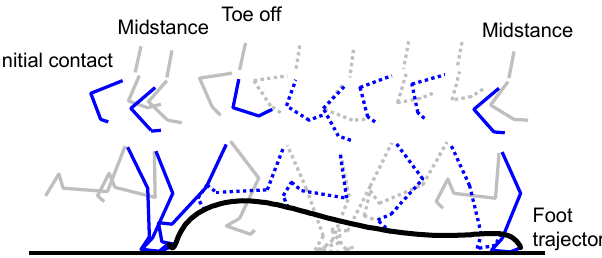
Figure 2. Visualization of detected initial contact (IC), midstance (MS), and toe-off (TO) events using the acceleration data.